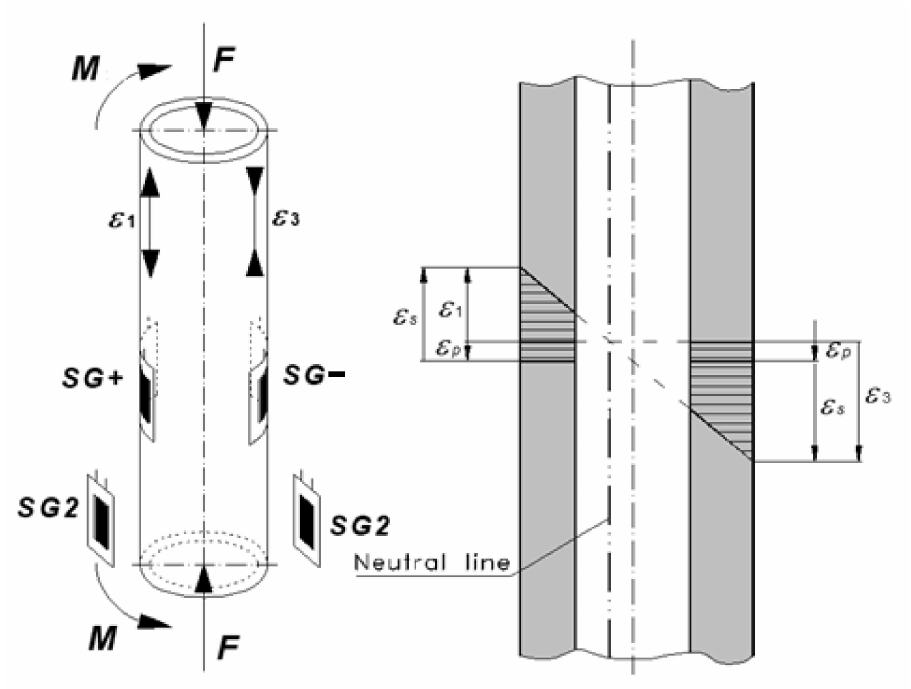
Figure 8. Arrangement of the strain gauges with an image of the strain distribution. In this case, the bending strains are significantly greater than the pressure